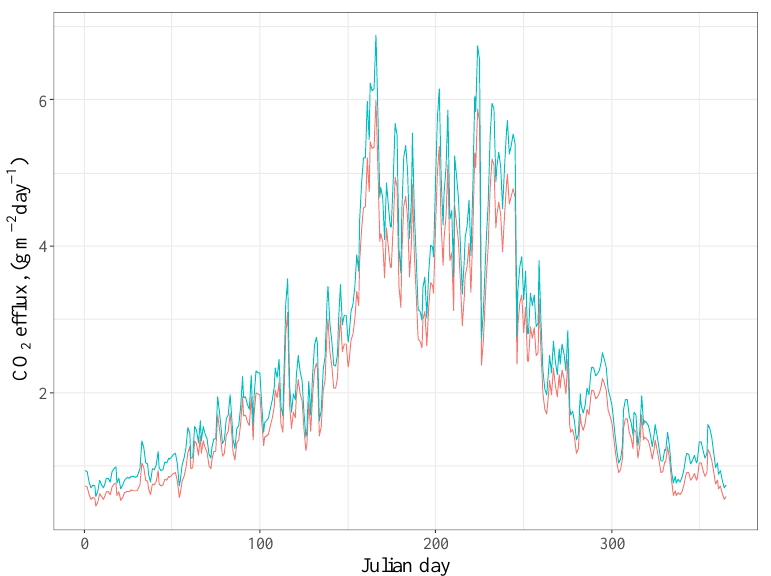
Figure 8. Daily CO 2 efflux (g m − 2 d − 1 ) expected in 2050 in Karcag, Hungary, calculated with the exponential model. With the consideration of the 95% confidence interval, the highest and the lowest estimations are indicated with blue and red lines, respectively.